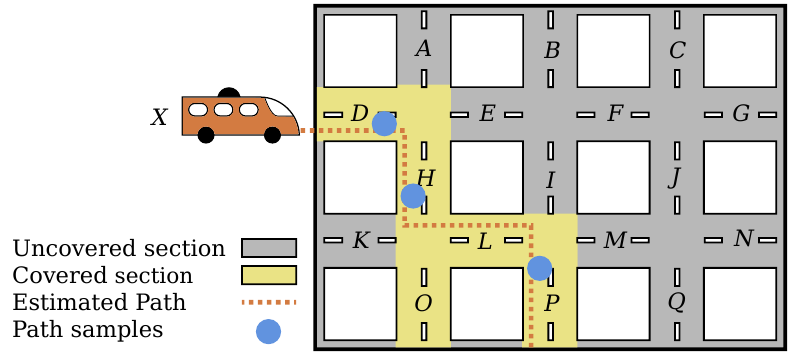
Figure 2. Reconstruction of a bus path using samples as input for Google Snap to